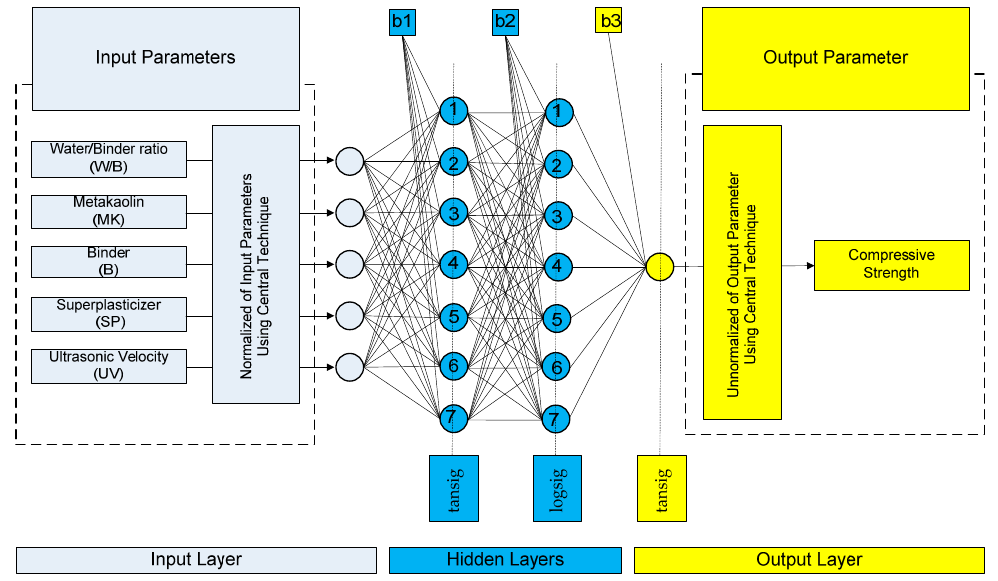
Figure 4. Architecture of the optimum with two hidden layers 5-7-7-1 BPNN model for the case of compressive strength of sandcrete materials based on Pearson’s correlation coefficient R.